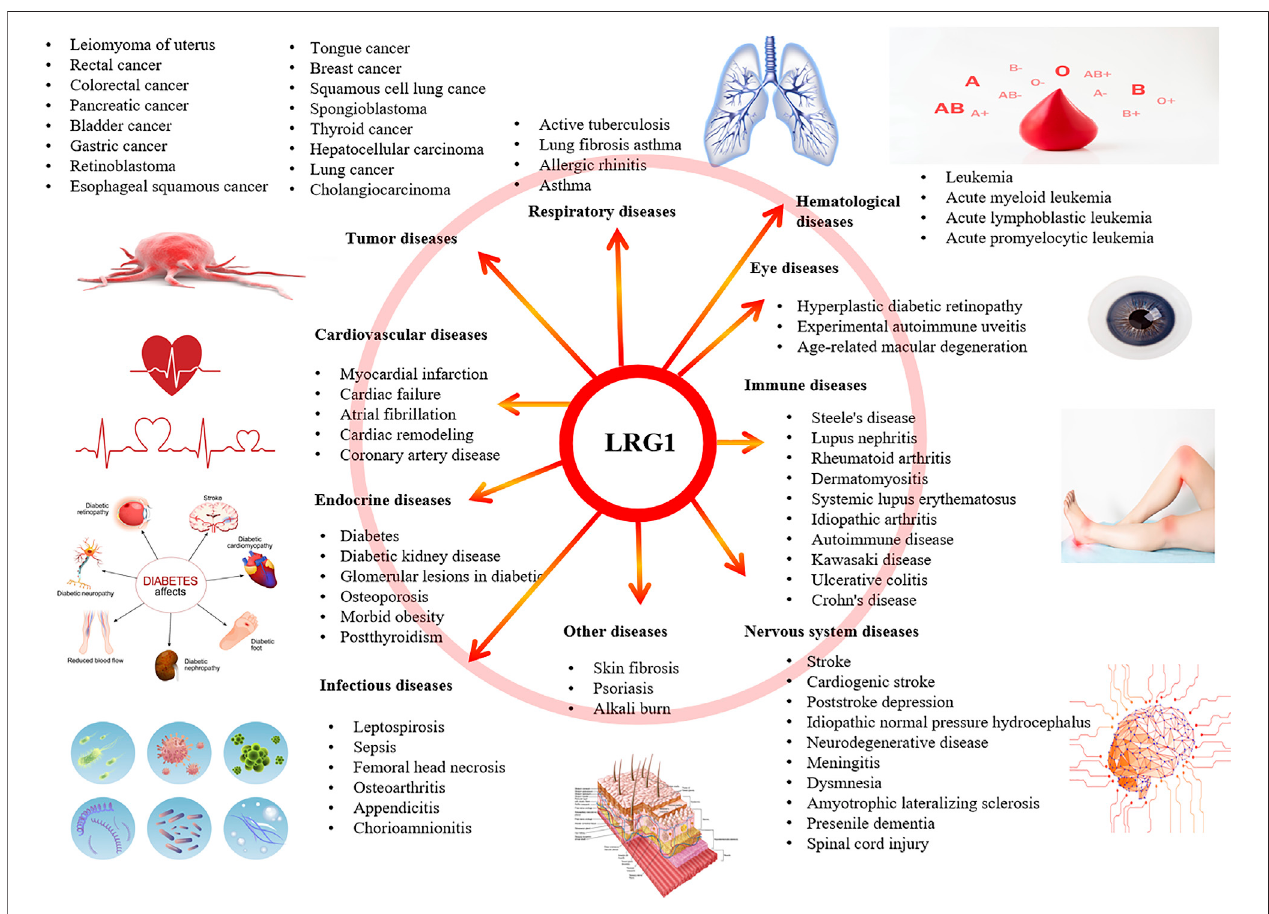
FIGURE 1 | LRG1 involved in the related